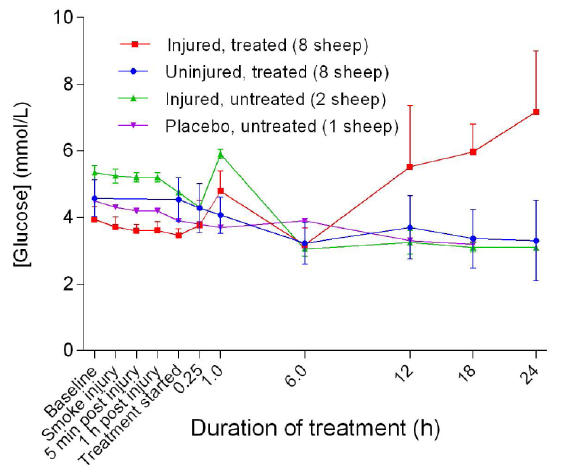
Figure 18. Blood glucose concentration (Mean ± SD) in smoke and non-smoke injured sheep that received extracorporeal life support as compared to that in untreated controls.